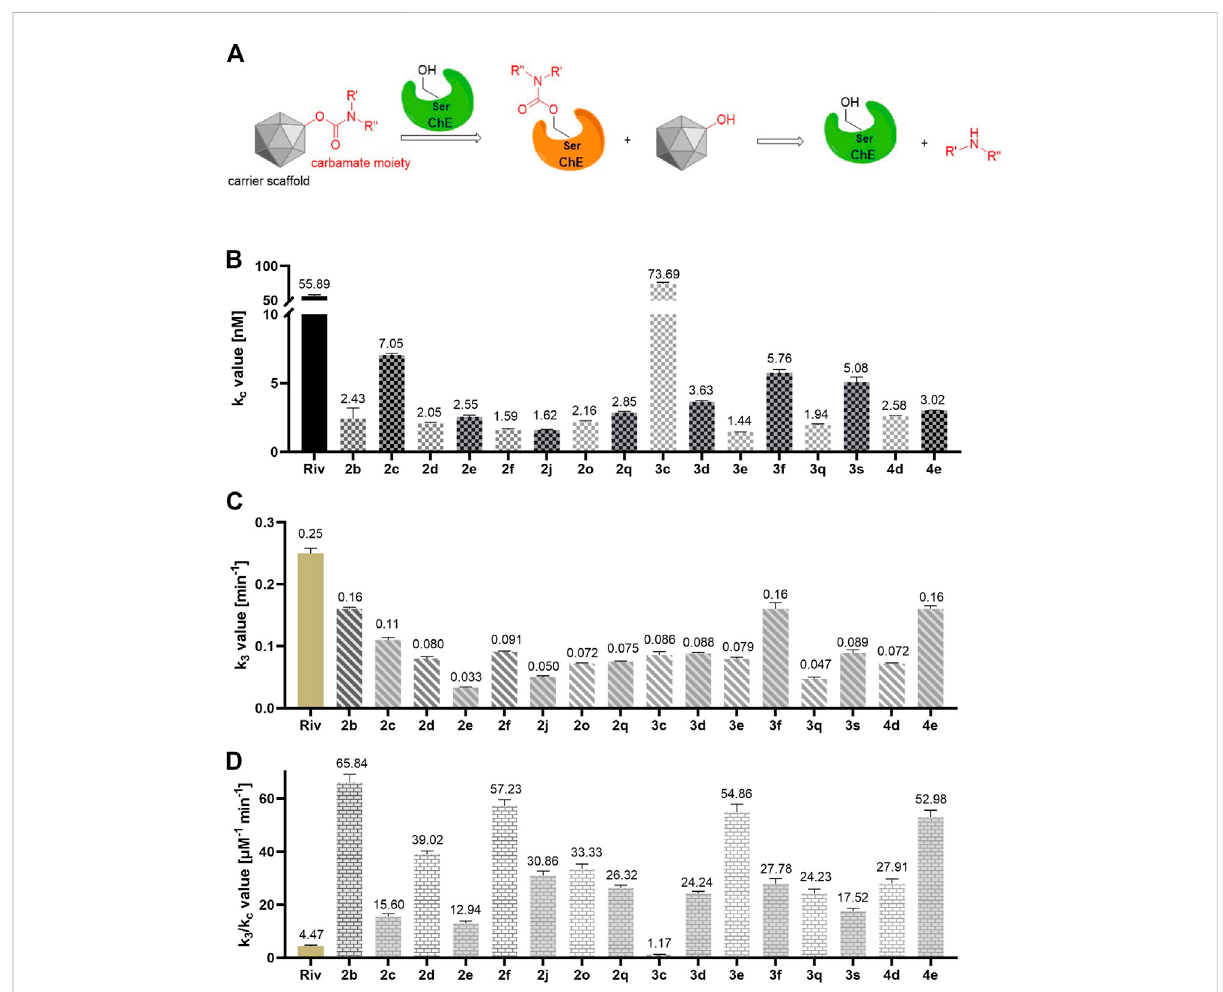
FIGURE 8 (A) The reported pseudo-irreversible inhibition mode of carbamylated derivatives on ChE. (B) The equilibrium constant (k c ) values of tested compounds. (C) The carbamylation rate constant (k 3 ) values of tested compounds. (D) The k 3 /k c values of the tested compounds. All these data are the mean ± SD of triplicate in three independent